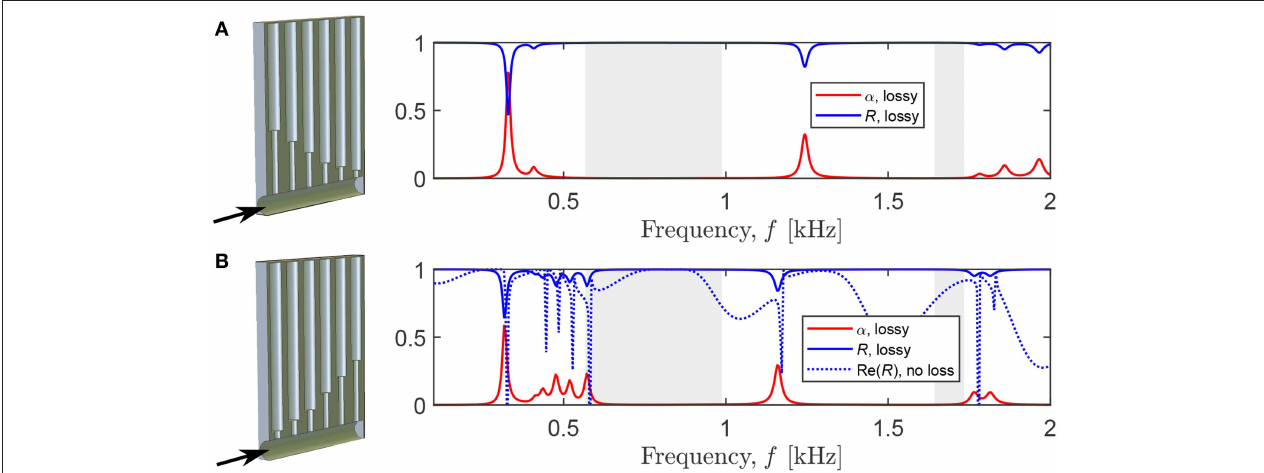
FIGURE 4 | The reflection (blue) and absorption (red) coefficients for the panels with periodically arranged rigidly-backed cavities loaded by six detuned HRs. The black arrow indicates the direction of incident sound. Shaded regions indicate the band gaps evaluated by the dispersion analysis (only the two wide band gaps are presented). The arrangement of the HRs with gradually (A) decreasing and (B) increasing length of a